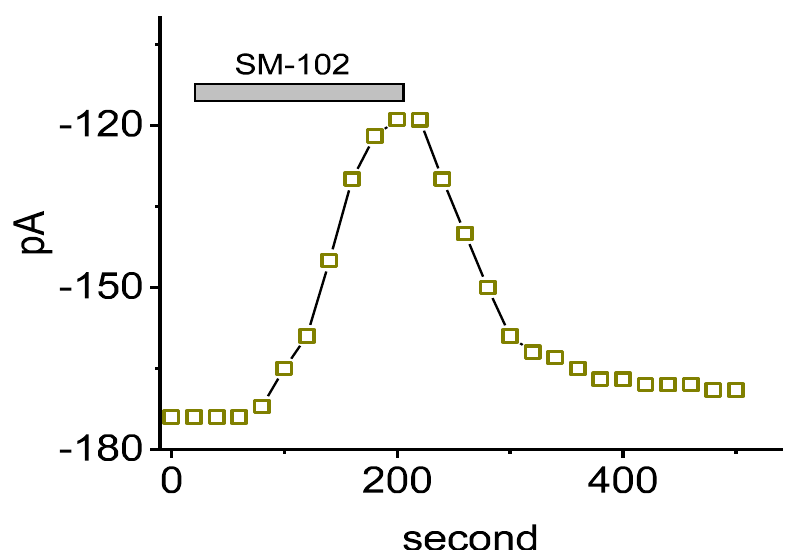
Figure 1. Time course showing effect of SM-102 (300 μM) on I K(erg) recorded from GH 3 cells. Cells were bathed in high-K + , Ca 2+ -free solution and the recording pipette was filled in a K + -enriched (145 mM) solution. Each current (indicated in open squares) was evoked by the hyperpolarizing pulse from − 10 to − 90 mV with a duration of 1 sec at a rate of 0.05 Hz, and the amplitude at the beginning of hyperpolarizing pulse was measured. The horizontal bar shown above indicates the application of 300 μM SM-102.